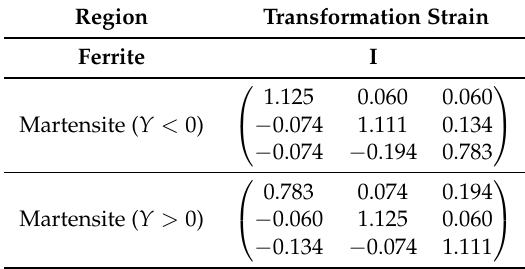
Table 5. The transformation strain values applied to the grains in Figure